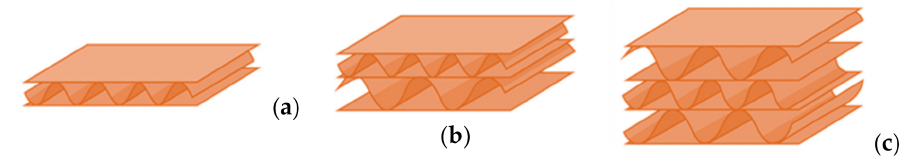
Figure 1. Board styles: ( a ) single-wall; ( b ) double-wall; ( c ) triple-wall. Reprinted with permission from ref. [12]. Copyright 2021 Elsevier.